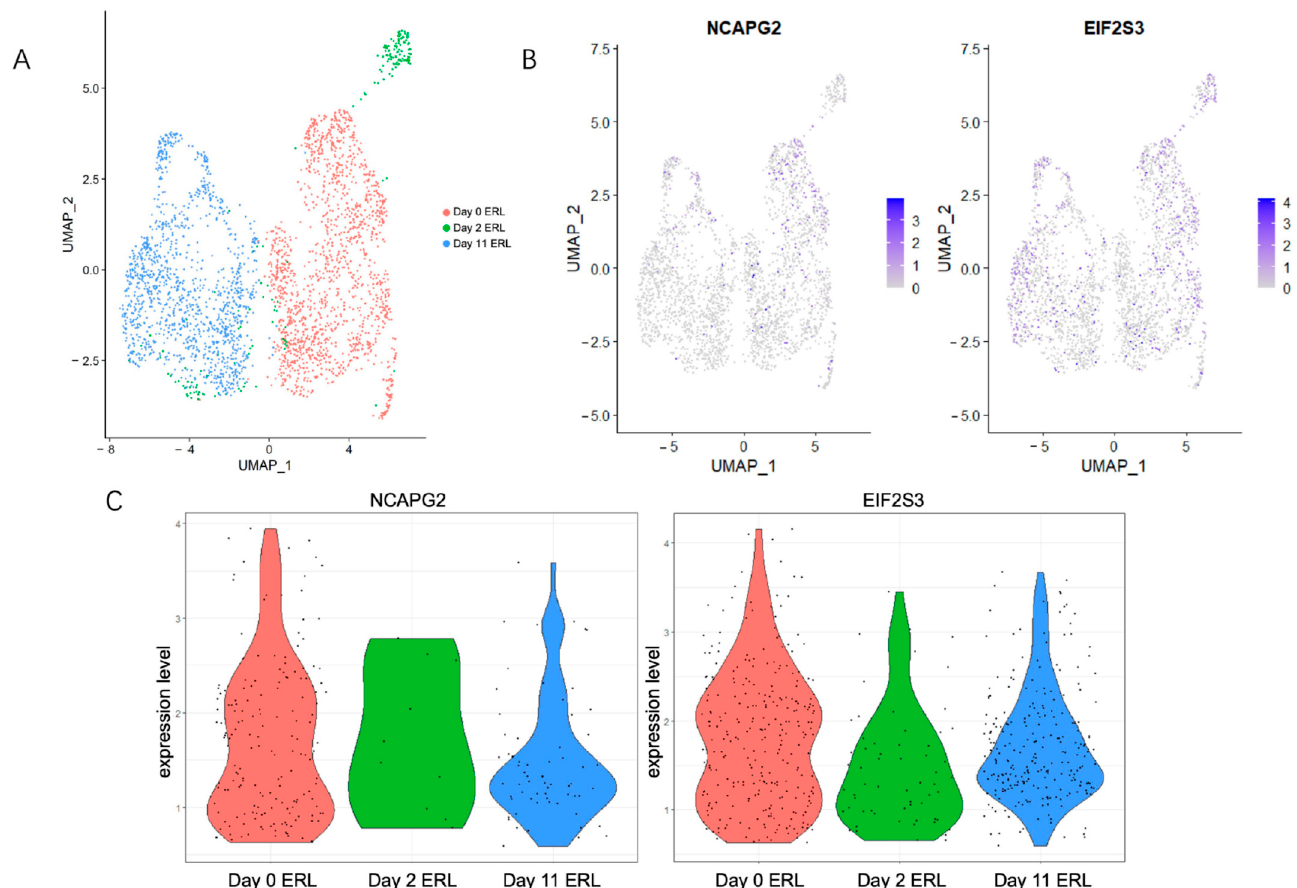
Figure 7. Single-cell RNA sequencing (scRNA-seq) analysis using GSE134841 . ( A ) Visualization of scRNA-seq in three datasets using UMAP. ( B , C ) UMAP plots and violin plots showing the expression of NCAPG2 and EIF2S3 in different cell populations.